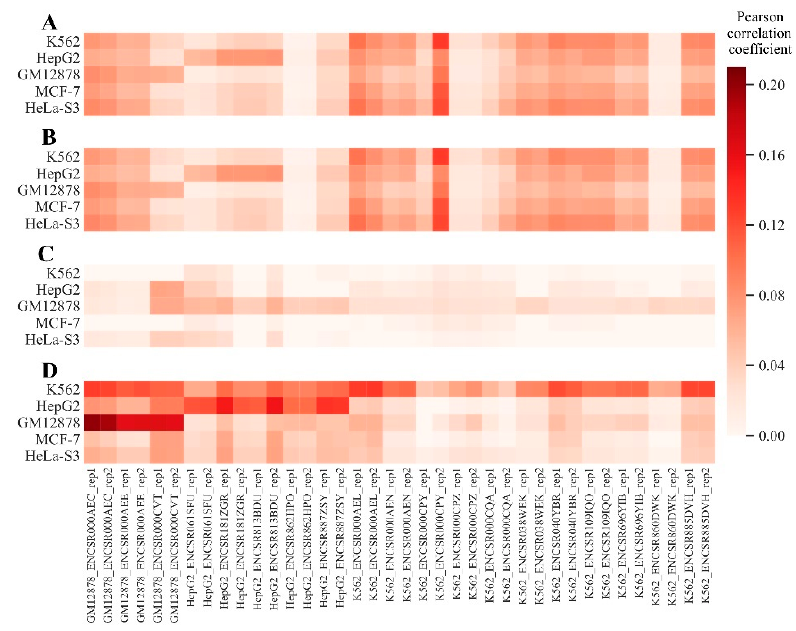
Figure 1. Correlations of H3K4me1 histone modification profiles with the RNA sequencing gene expression data. The histone modification profiles (vertical axis) were compared with normalized gene expressions (abscissa) for 6 GM12878 , 10 HepG2 and 22 K562 cell line RNA sequencing experiments. Pearson correlations were measured for ( A ) set of all known genes; ( B ) set of protein coding genes; ( C ) set of microRNA genes and ( D ) set of long non-coding RNA genes.